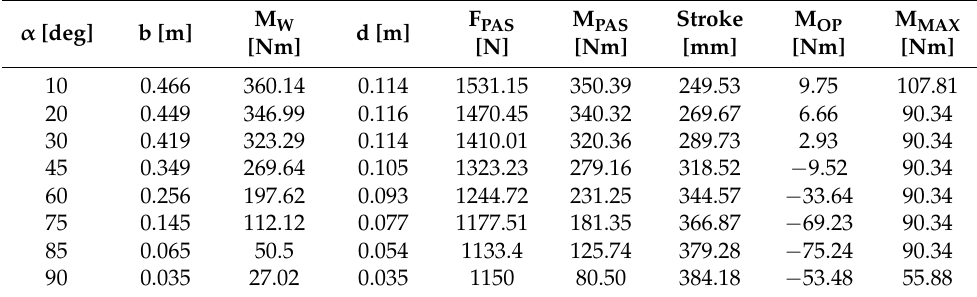
Table 3. Moments’ comparison table, where the last column indicates the limits that should not be exceeded.